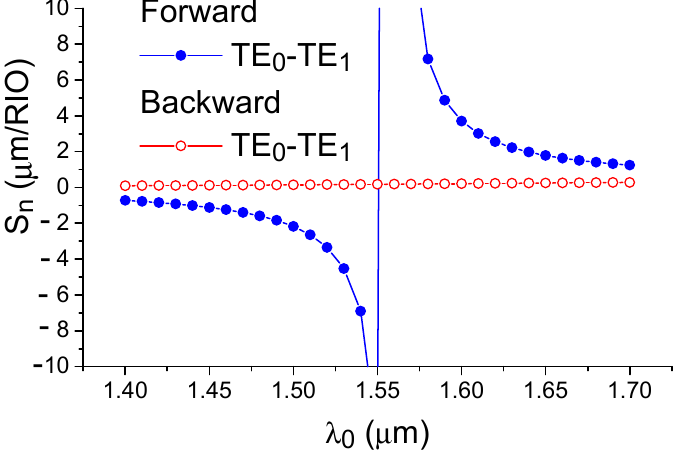
Figure 3. Homogeneous sensitivity dependence on the wavelength. It is seen the resonant behavior of the sensitivity for the forward diffraction, and the monotonic behavior for the backward diffraction. Calculation by the effective index method.